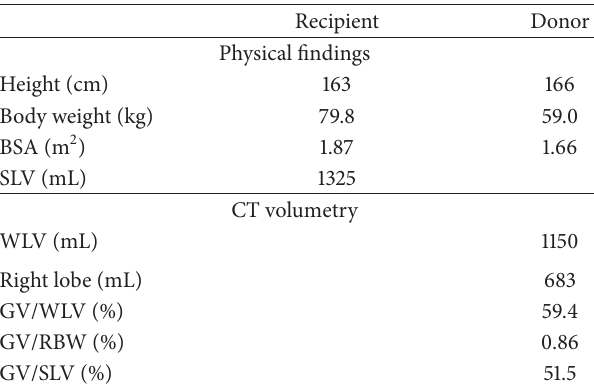
Table 2: Preoperative estimations of the recipient’s standard liver volume and donor’s graft